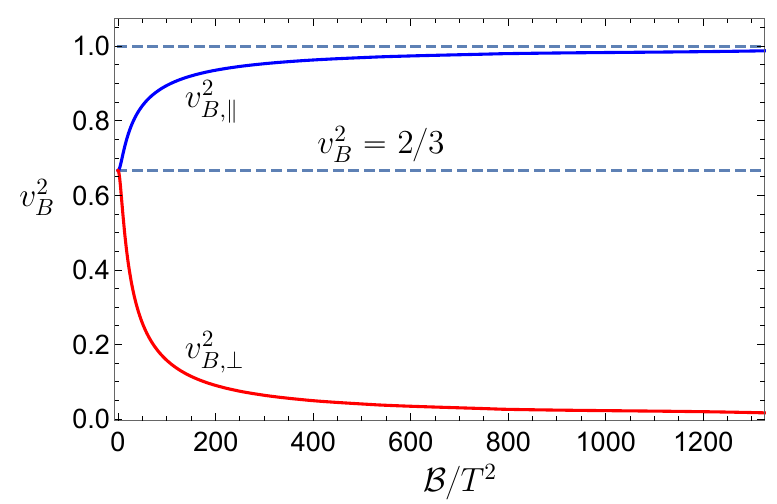
Figure 3 . Butter(cid:13)y velocity squared v 2 represents the butter(cid:13)y velocity along the direction of the magnetic (cid:12)eld, while the red curve stands for the butter(cid:13)y velocity along any direction perpendicular to the magnetic (cid:12)eld. The horizontal lines represent either the conformal result v 2